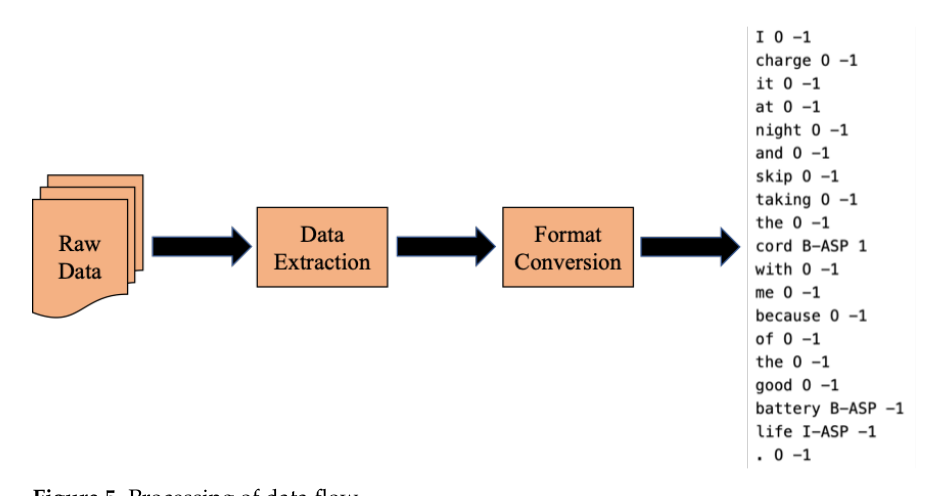
Figure 5. Processing of data flow.